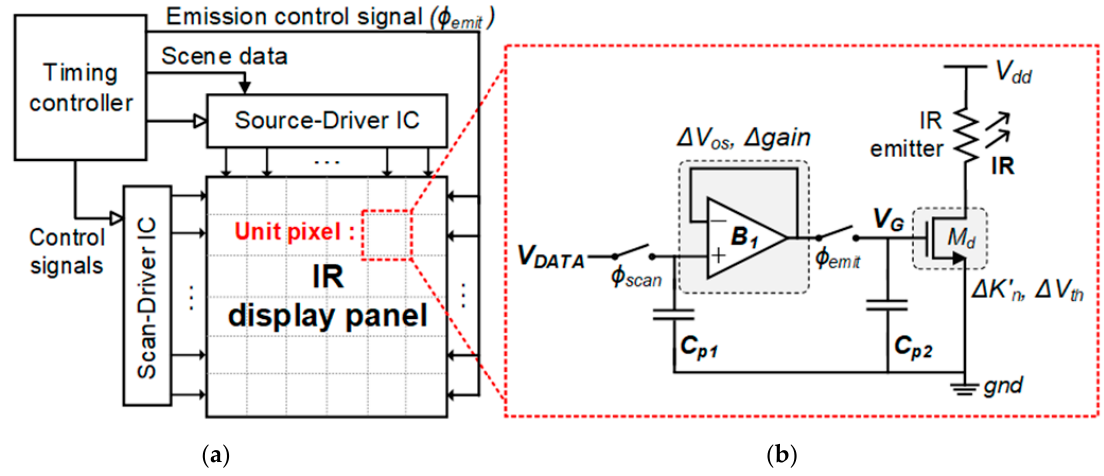
Figure 1. ( a ) Overall block diagram; ( b ) conventional read-in integrated circuits (RIIC) unit pixel.